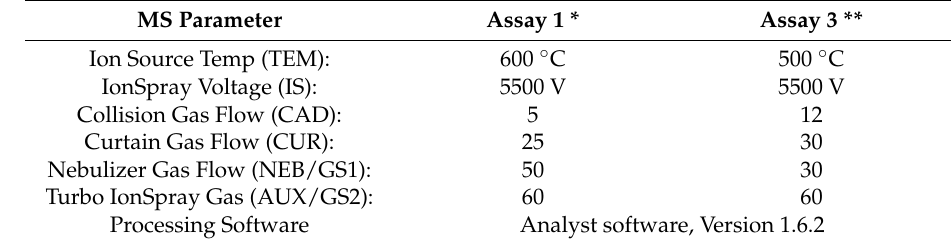
Table 2. Source Parameters ABI SCIEX API